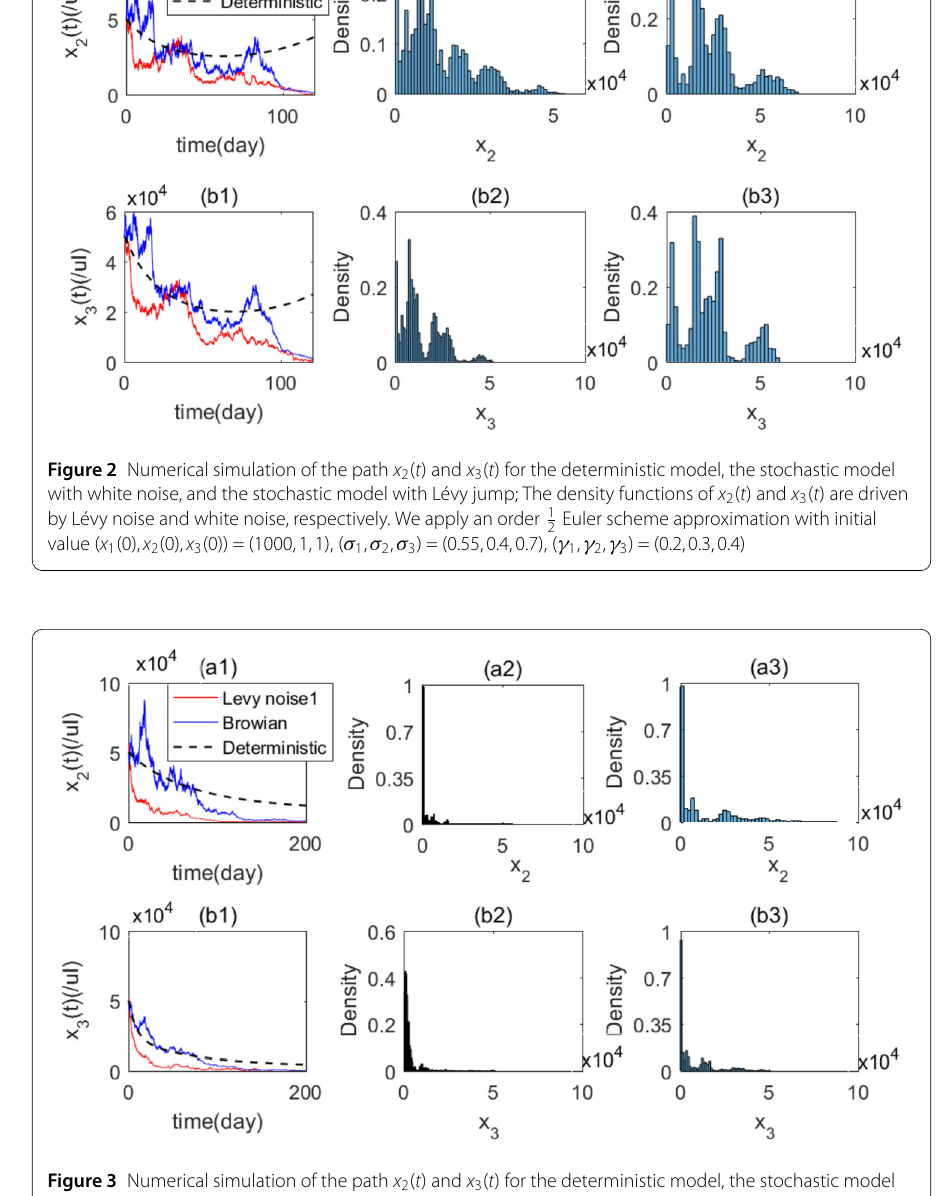
Figure 3 Numerical simulation of the path x 2 ( t ) and x 3 ( t ) for the deterministic model, the stochastic model with white noise, and the stochastic model with Lévy jump; The density functions of x 2 ( t ) and x 3 ( t ) are driven by Lévy noise and white noise, respectively. We apply an order 1 Euler scheme approximation with initial 2 value ( x 1 (0), x 2 (0), x 3 (0)) = (1000,1,1), ( σ 1 , σ 2 , σ 3 ) = (10,5,1.8), ( γ 1 , γ 2 , γ 3 ) =